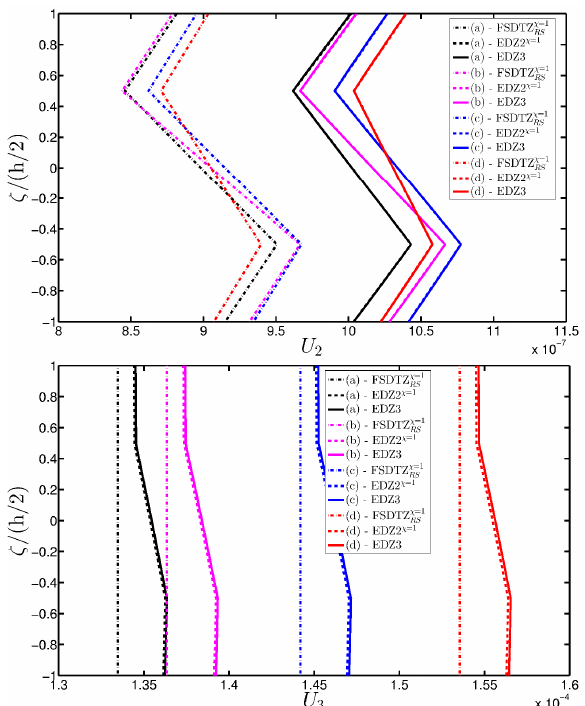
Figure 23. Through-the-thickness profiles of displacement components [m] for the FCFC soft-core cylindrical surface computed at the point B for different HSDTs. The effect of the damage is investigated by varying the parameters of the function